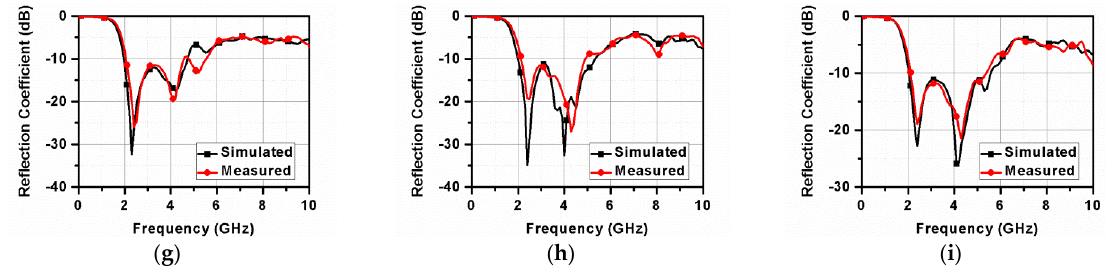
Figure 18. Plot of ( a ) S 11, ( b ) S 22, ( c ) S 33, ( d ) S 44, ( e ) S 55, ( f ) S 66, ( g ) S 77, ( h ) S 88, ( i ) S 99.